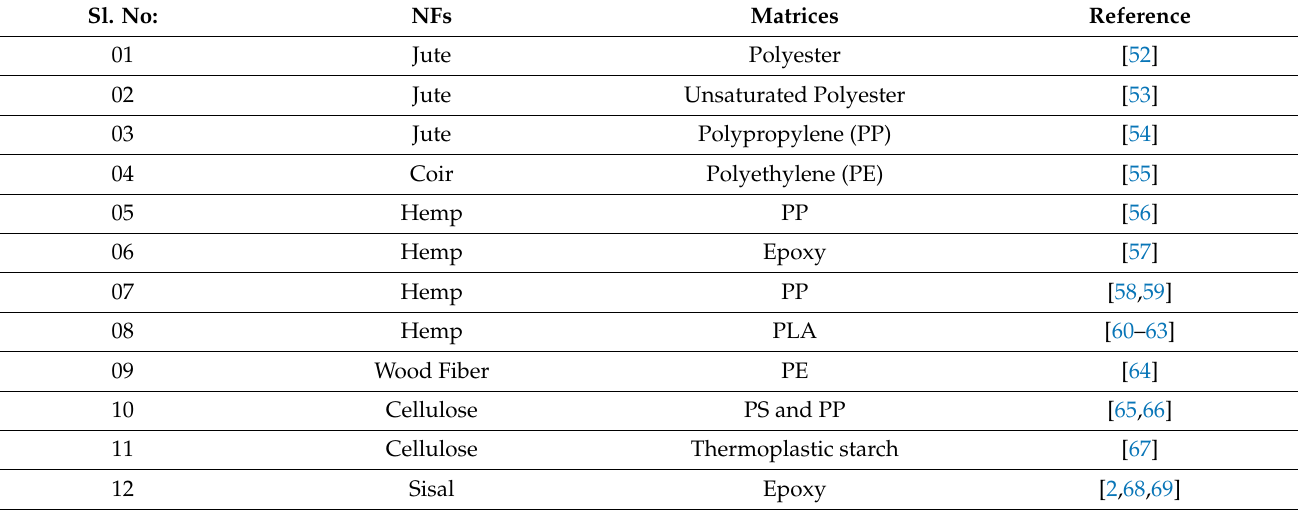
Table 2. Reported some works on NF